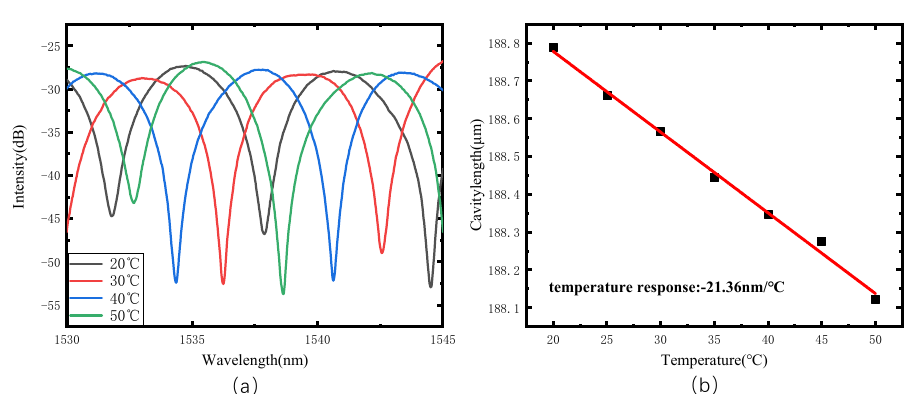
Figure 17. Test results after 7 days.